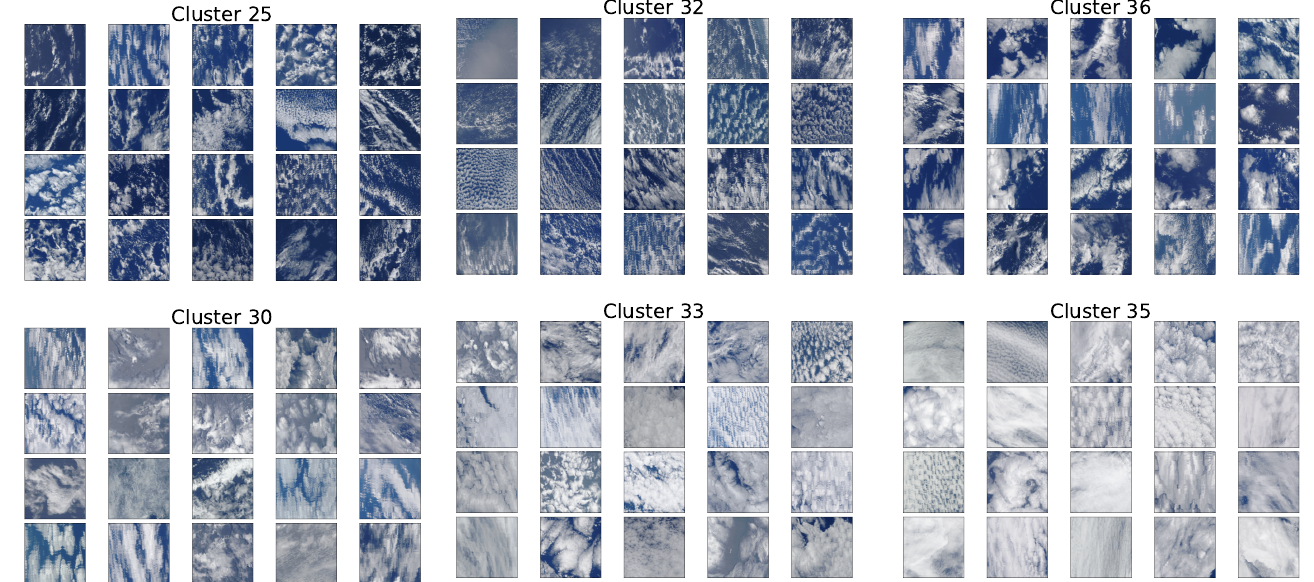
Figure 10. Selected MODIS true color images [52] for the six clusters that dominate open-cell (upper row: #25, #32, and #36) and closed-cell (lower row: #30, #33, and #35) stratocumulus clouds in Figure 9. Surtitles show the cluster numbers. We show the 20 patches closest to OC-Patches HAC centroids.